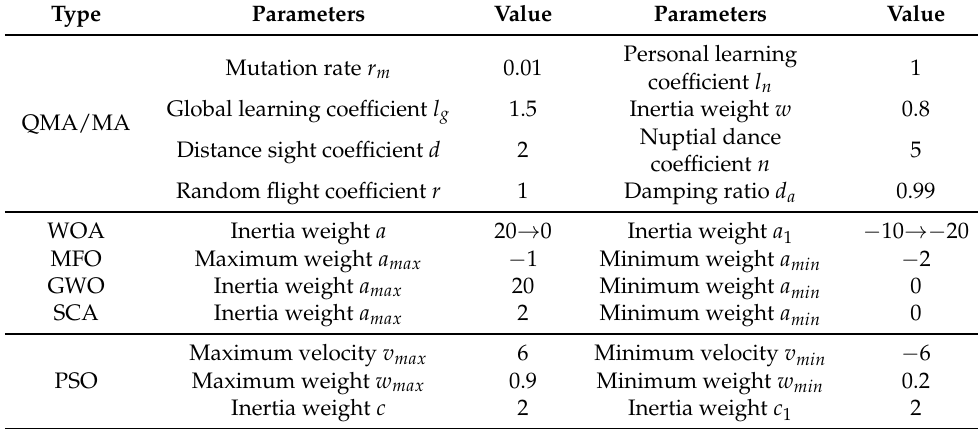
Table 2. Algorithm